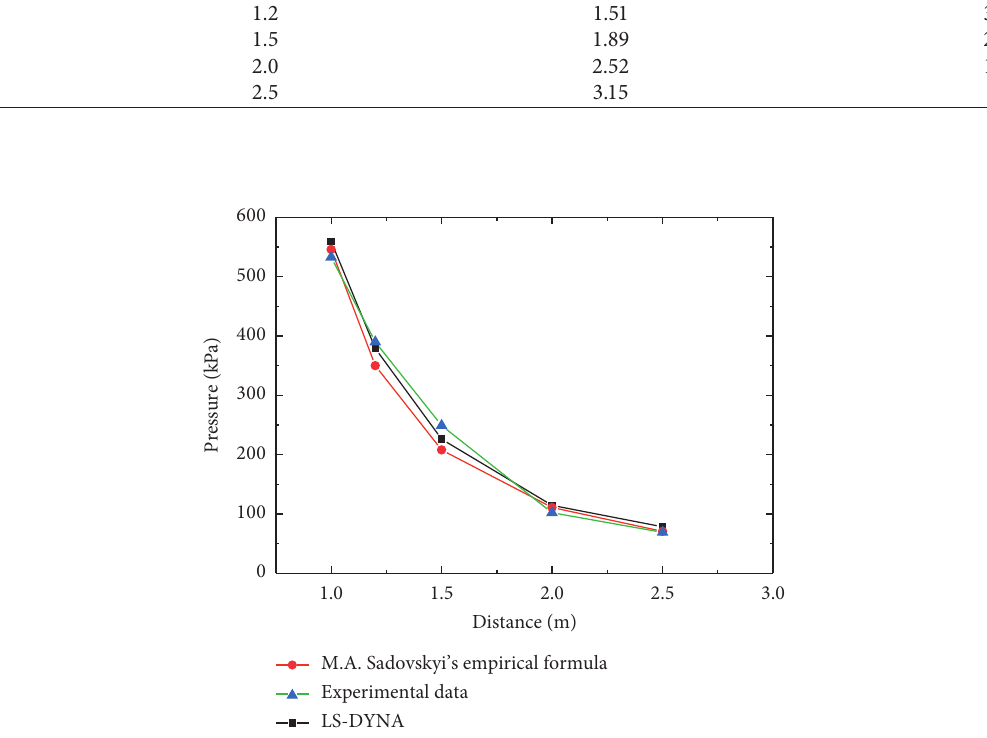
Figure 4: Comparison of experimental and estimated data.